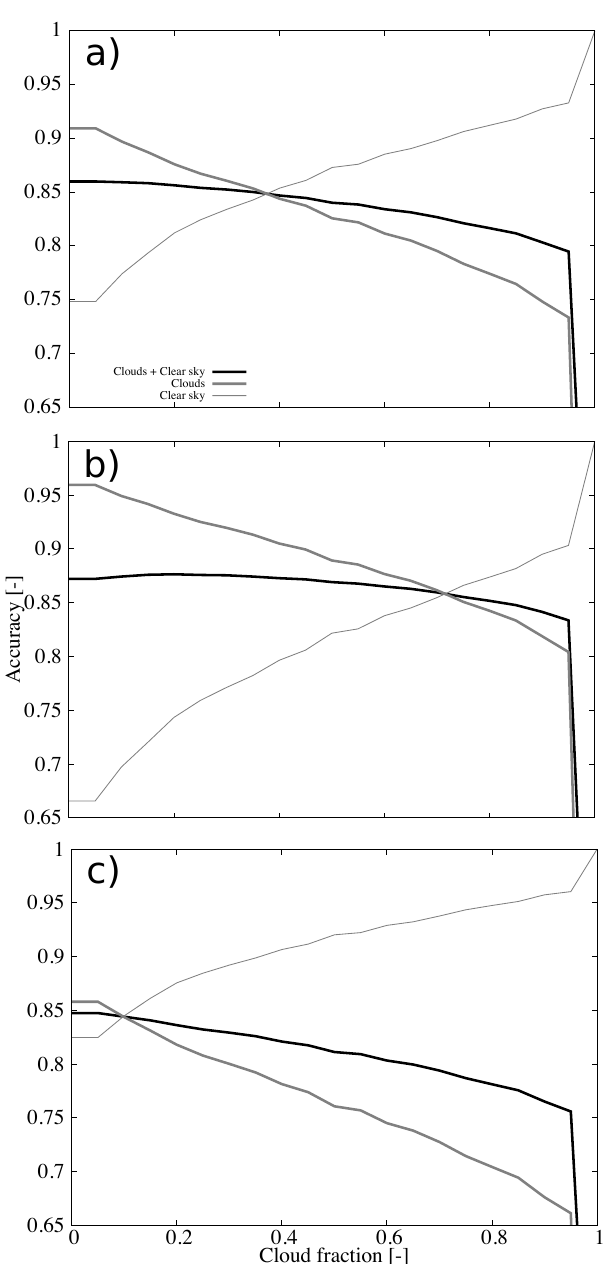
Figure 4. Accuracy as a function of the cloud fraction threshold for ( a ) all retrievals, ( b ) daytime retrievals, and ( c ) nighttime retrievals. The accuracy of the clouds and clear sky detection, cloud detection, and clear sky detection are shown (see